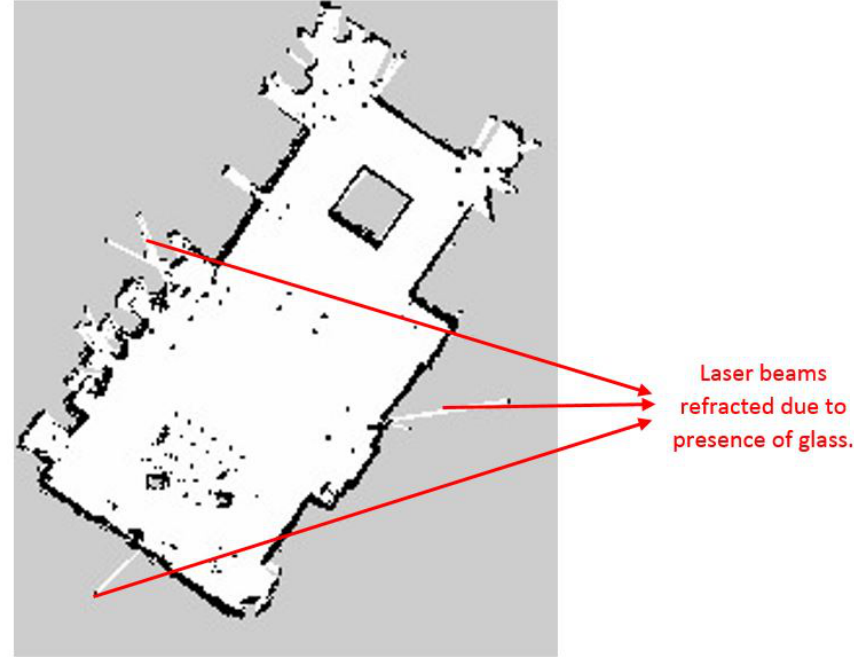
Figure 14. Map generated using the Lidar sensor.